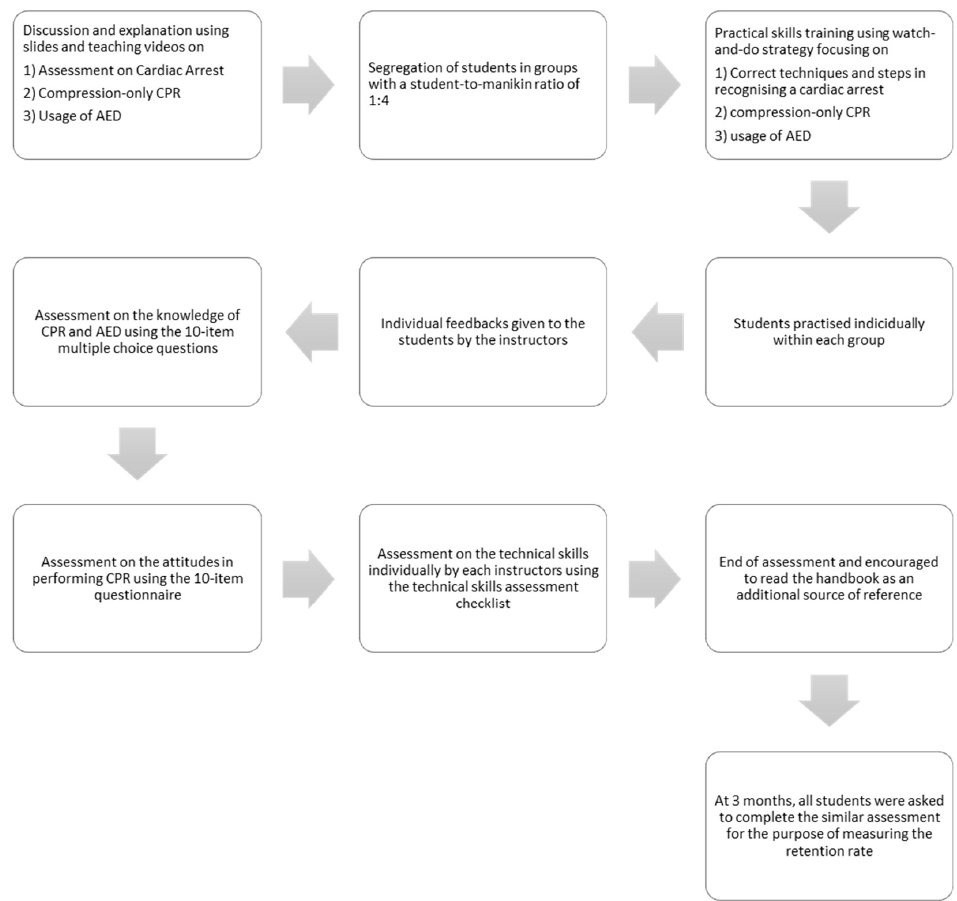
Figure 2. An overview of the course and assessment.